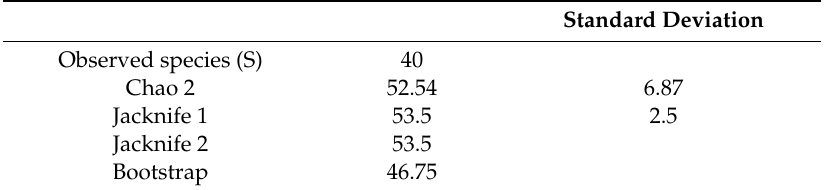
Table 3. Estimation of total ant species richness for the two areas.